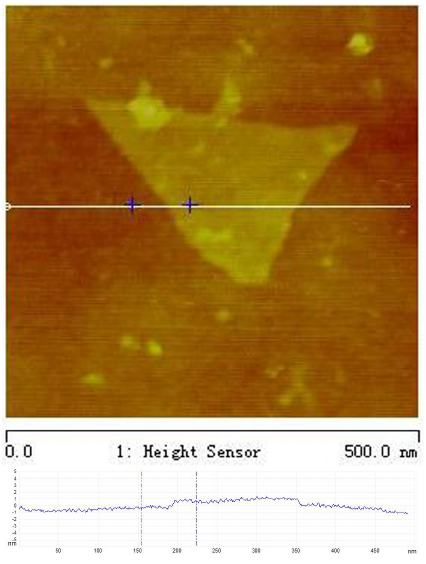
Figure 1: AFM image and high profile diagram of exfoliated GO